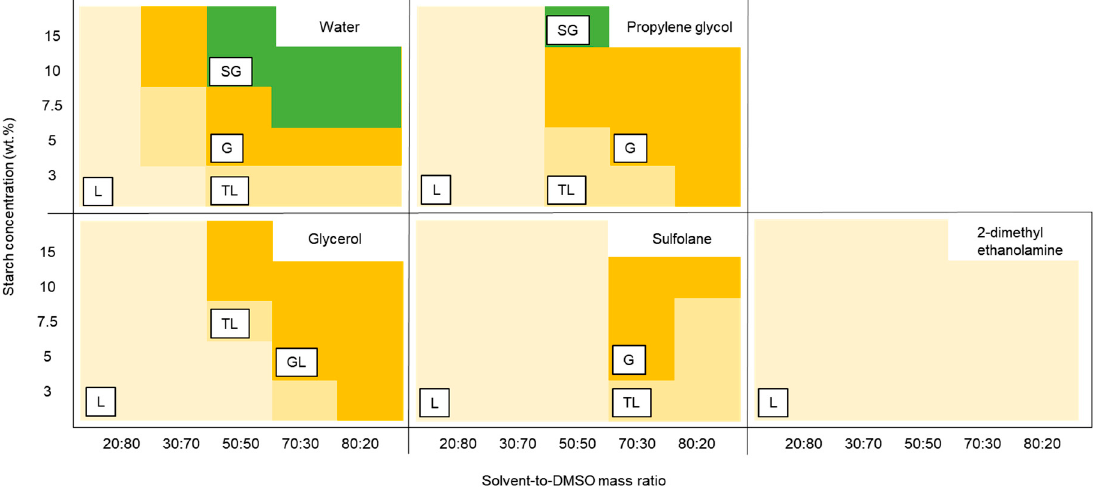
Figure 1. Qualitative phase diagrams of the samples containing di ff erent solvents, with increasing starch concentration and solvent-to-DMSO mass ratio. The letters represent the gelation behavior of samples: liquid (L), thick-liquid (TL), gel-like (G), and strong gel (SG).